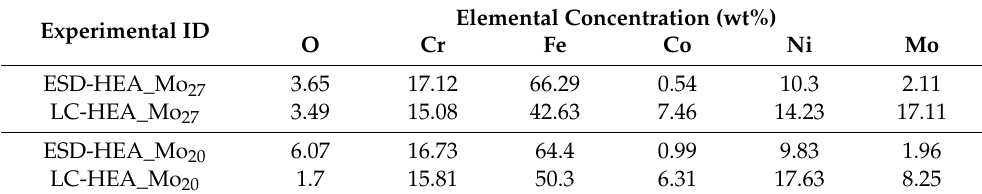
Table 8. Chemical composition of the HEA_Mo 20 deposited with ESD and LC techniques from EDX analysis after the dry sliding wear test. The EDX map spectrum from worn regions with parallel grooves in the SEM images in Figure